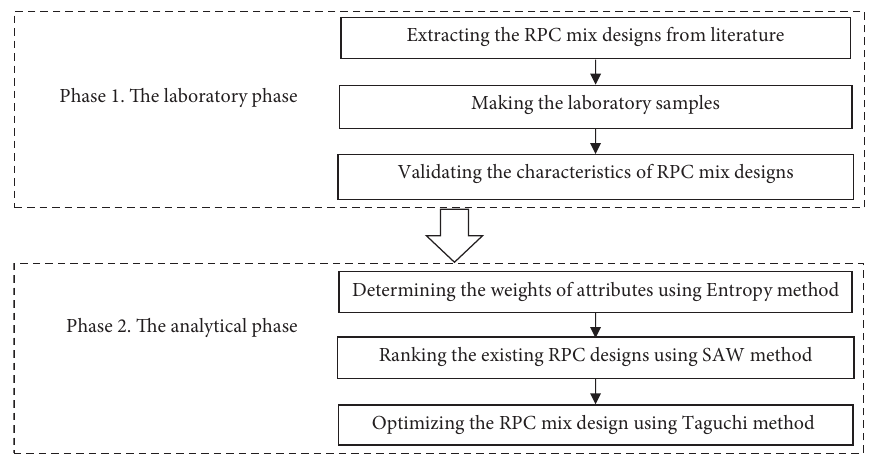
Figure 3: Scheme of proposed